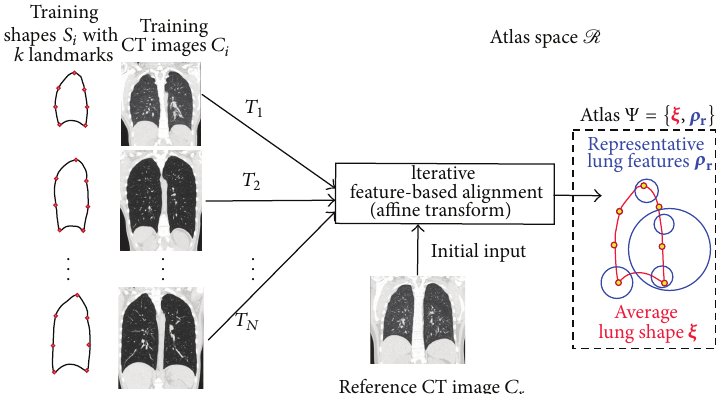
Figure 1: Generation of the feature-based atlas Ψ , comprising the average lung shape 𝜉 and representative lung features 𝜌 r in the atlas space R . Note that the features 𝜌 r are derived from training CT images and encode both appearance and geometric properties [11]. For sake of clarity, the above process is shown only for the right lung.